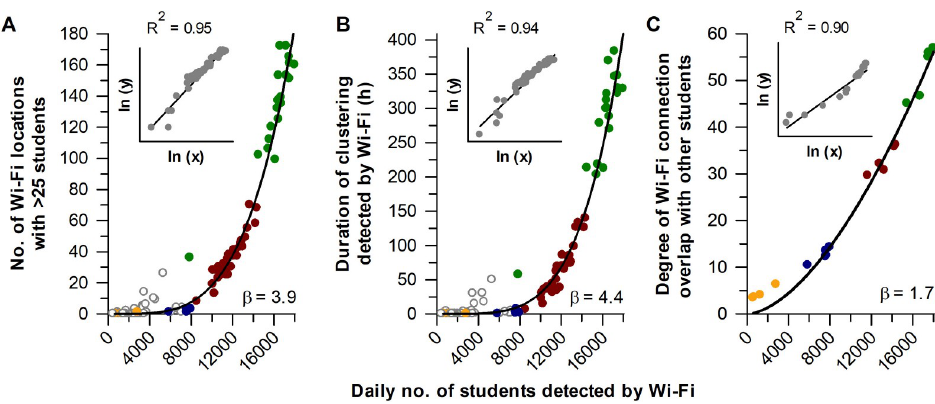
Fig 4. Student clustering showed power law scaling with the number of students on campus. Student mixing showed accelerated growth with daily population size, including ( A ) the number of Wi-Fi locations with a student cluster, ( B ) the duration of student clustering, and ( C ) the degree of spatiotemporal overlap of students with their peers. Data are shown for the second semester of the 2019/20 school year during the COVID-19 outbreak. Each dataset was fitted with a power law function, with β representing the scaling exponent. Insets show results for linear regression after taking the natural logarithm of each variable. Circle colours correspond to different parts of the semester with normal in-class learning (green), e-learning for classes with > 50 students (red), e-learning for classes with > 25 students (blue), and e-learning for all classes (orange). In panels A and B , open circles indicate non-class days.